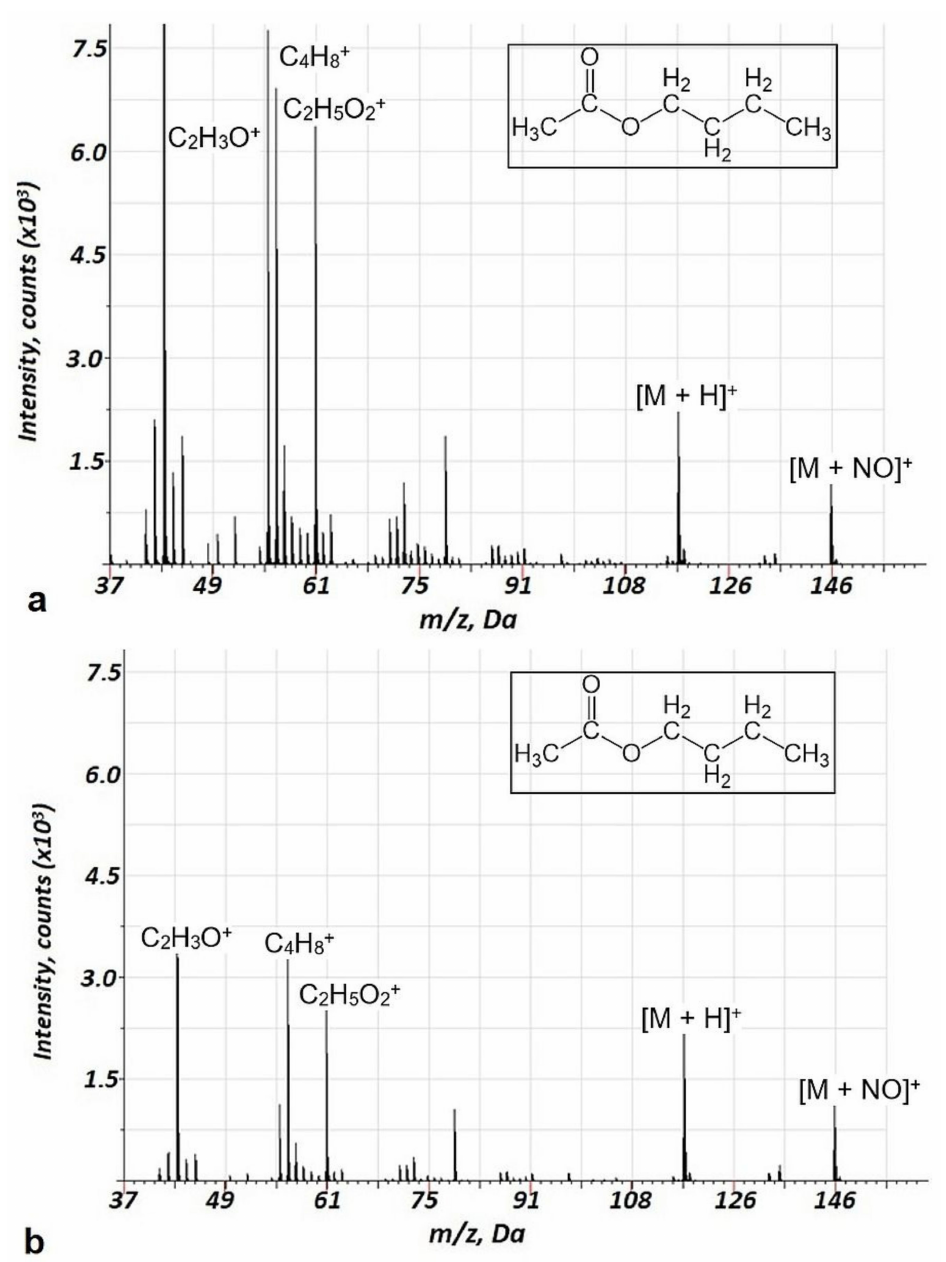
Figure 2. Background corrected mass spectrum ranges for butyl acetate in argon-air( a ) and air ( b ) glow discharge under Penning ionization. Acquisition parameters were as follows: repelling pulse delay 200 µ s, pulse duration 1.0 µ s, pulse period 900 µ s, ( a ) air pressure—110 Pa, Ar pressure—60